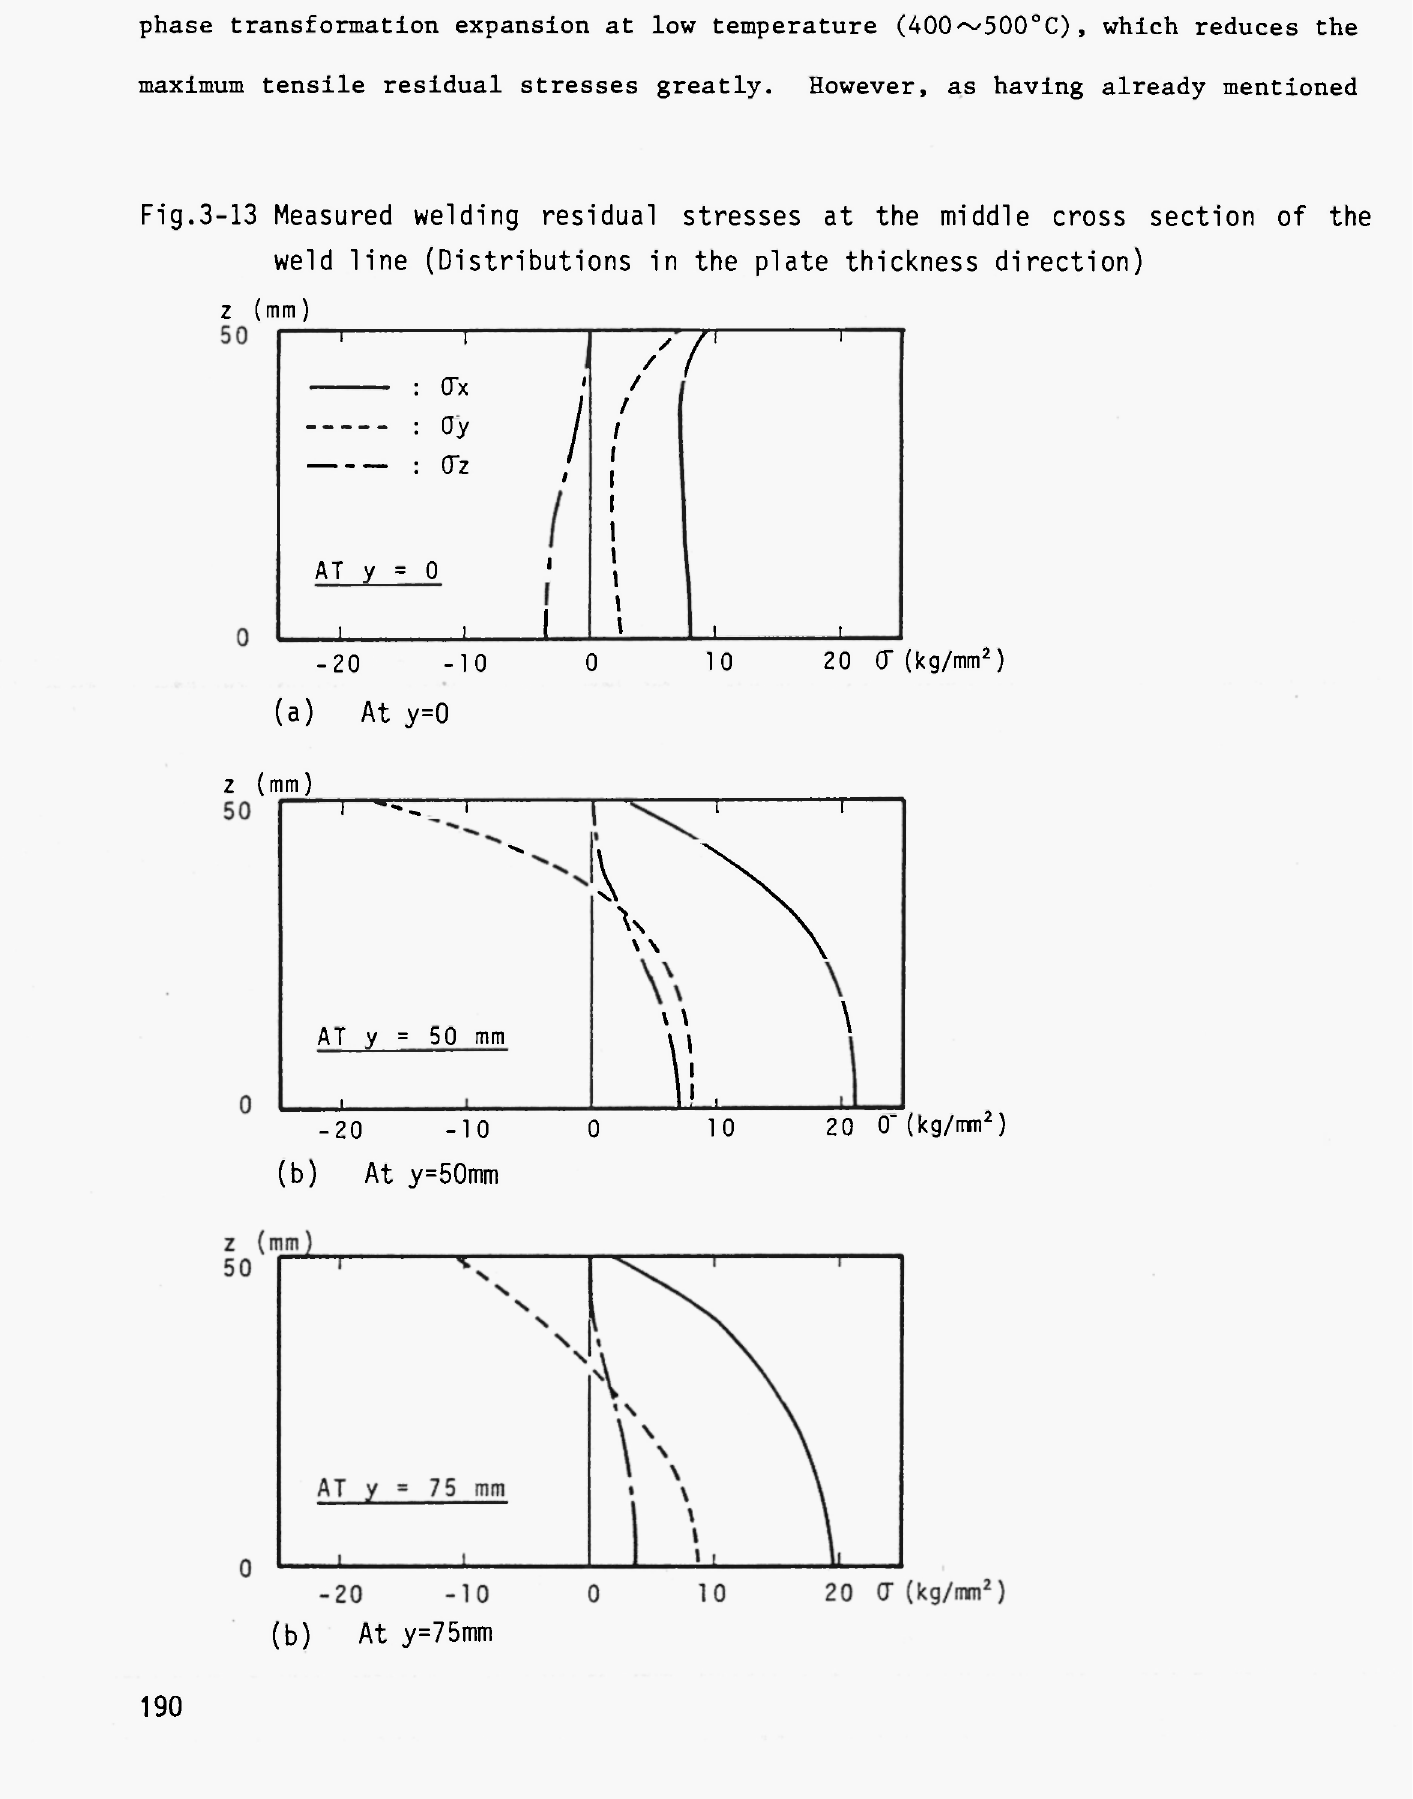
welding residual stresses at the middle cross section of the weld line (Distributions in the plate thickness